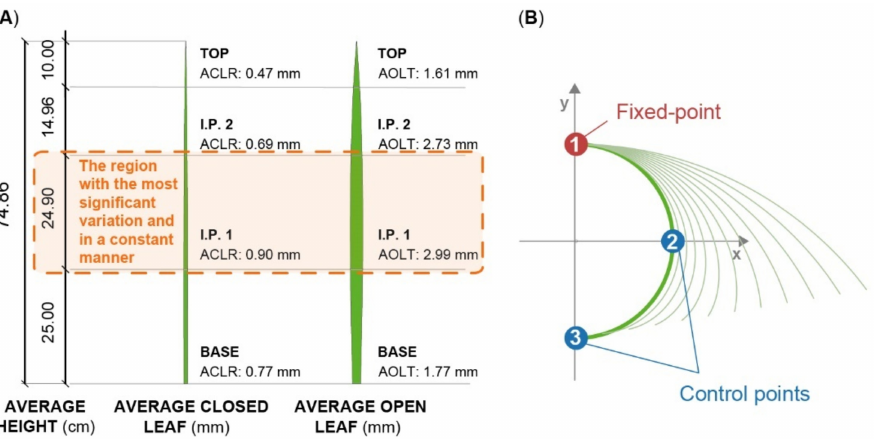
Figure 8. ( A ) An average leaf: height, closed and open leaf. For each of the four pre-determined points, we identified: ACLR and AOLW; ( B ) Conceptual process for defining the algorithm from (1) fixed point and (2–3) control points, which allow the leaf opening and closing. Source: Authors. Scheme 1 shows the average variation of leaf width in